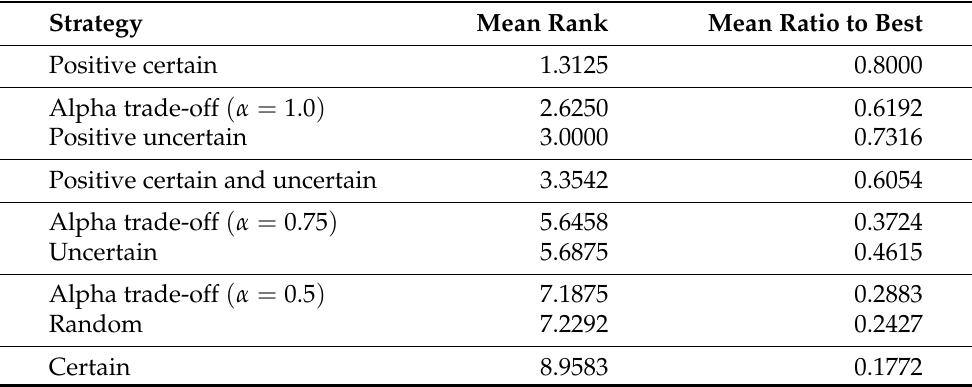
Table 9. AL strategies sorted according to mean rank of